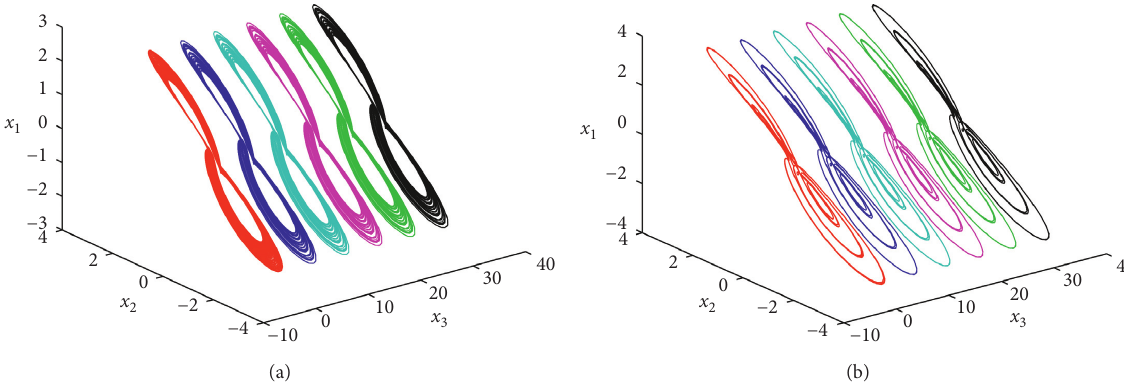
Figure 9: Coexisting six hidden attractors of system (2) from initial values ( 1 , 1 , 2 j π , 1 ) , j � 0 , 1 , 2 , 3 , 4 , 5. (a) Quasiperiodic attractors for a � 12, b � c � 1, and k � 12. (b) Periodic attractors for a � 20, b � c � 1, and k � 12.